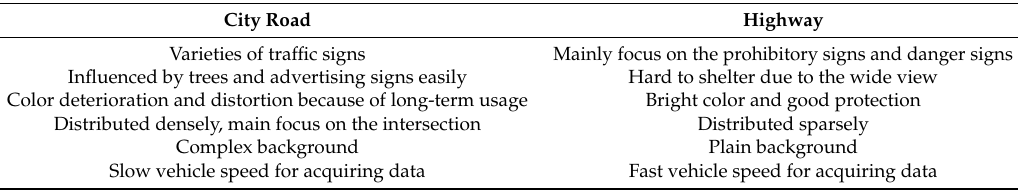
Table 2. The differences between city roads and highways.